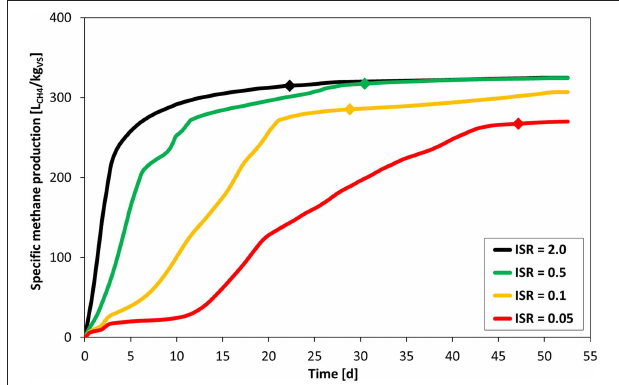
FIGURE 4 | Impact of inoculum-to-substrate ratio on the specific methane production. Plotted values are the mean of three replicate bottles for each condition. Diamonds indicate the time when the daily gas production was below 1% of cumulative production during 3 consecutive days.